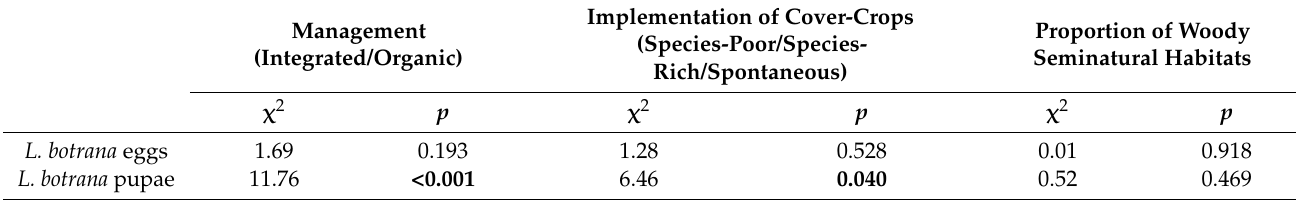
Table 3. Model outputs for predation rates of L. botrana eggs and pupae. Significant p -values are displayed in bold (degrees of freedom (df) =